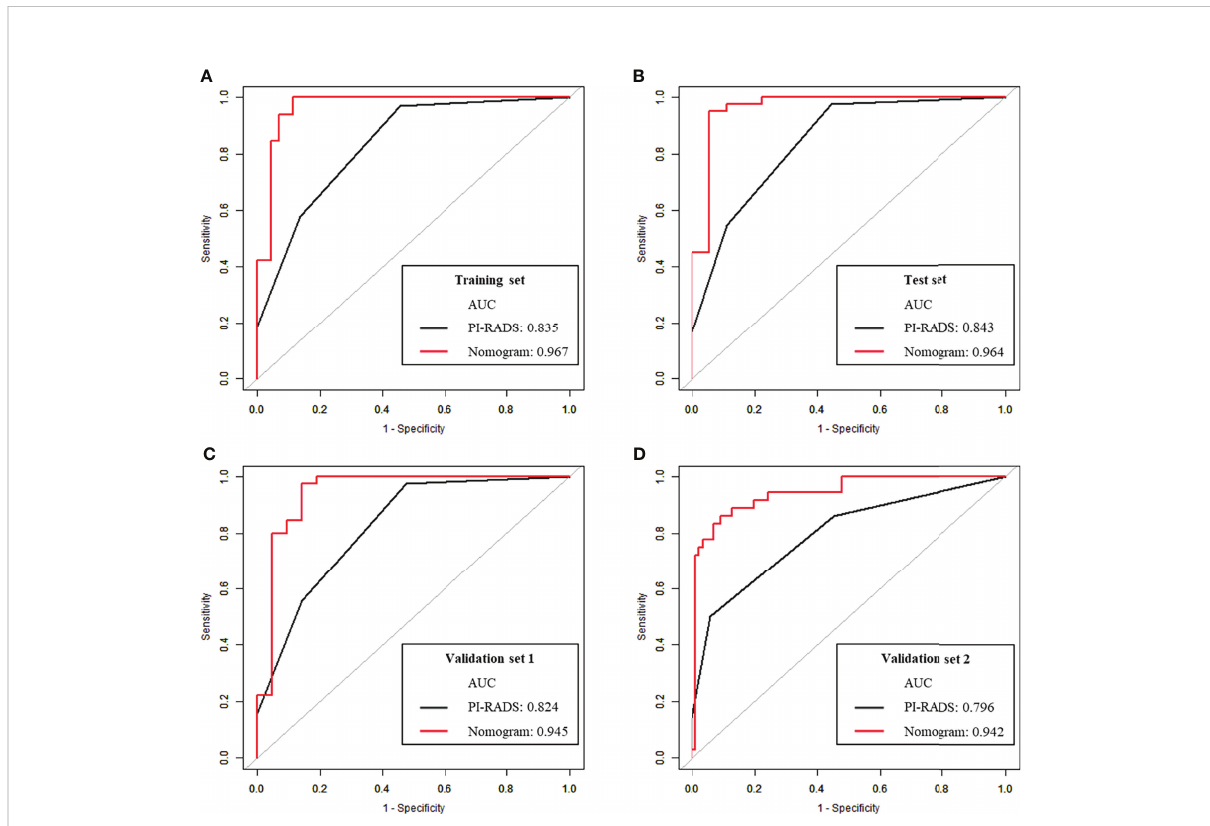
FIGURE 4 ROC curve analysis of the nomogram and PI-RADS for CS-PCa prediction. (A) In the training set. (B) In the test set. (C) In validation set 1. (D) In validation set